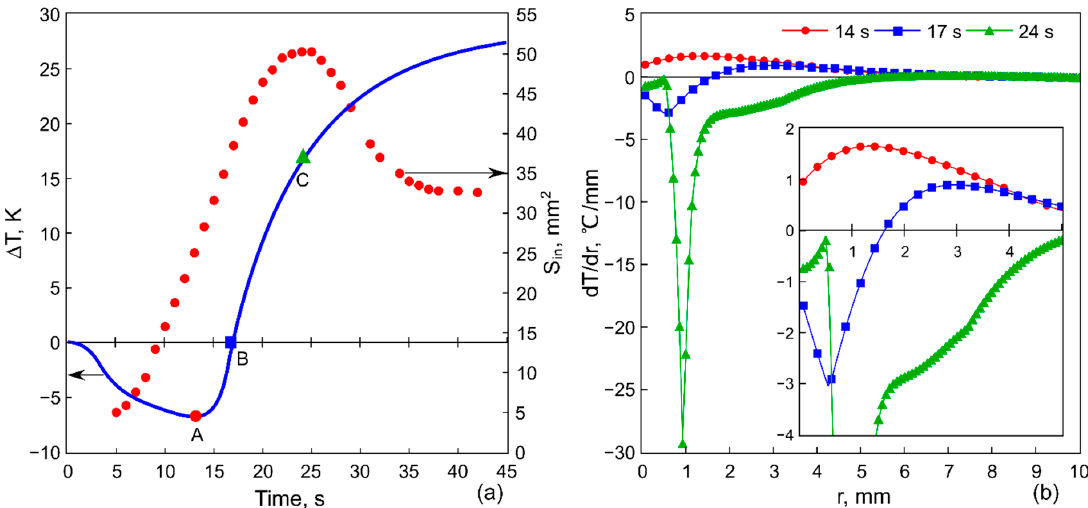
Figure 4. ( a ) The evolution of the inner area of the ring deposit (circle symbols) and the temperature variation on the copper rod relative to the ambient temperature (a solid line). ( b ) Radial temperature gradients at three different moments of time 14, 17 and 24 s.